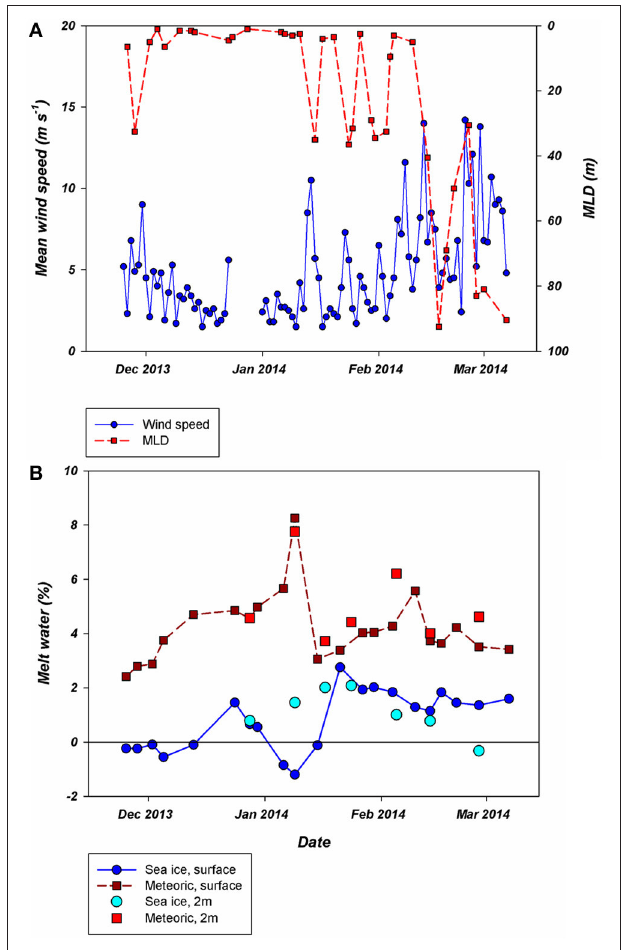
FIGURE 4 | (A) : Daily average wind speed (blue) and mixed layer depth (MLD) calculated using the depth of the maximum Brunt–Väisälä frequency. (B) : Different fractions of meltwater with different origins. Firstly, samples collected at the surface as part of the RaTS program are divided into the fraction of meteoric origin (dark red) and sea ice origin (dark blue). Additionally, a number of samples collected at the same site, but at 2m depth also show the two fractions (light red and blue, respectively) and illustrates the effect of very shallow meltwater lenses. All data were collected during the 2013–2014 season. Period 1 starts on December 6th, period 2 on January 15th and period 3 on February 10th.